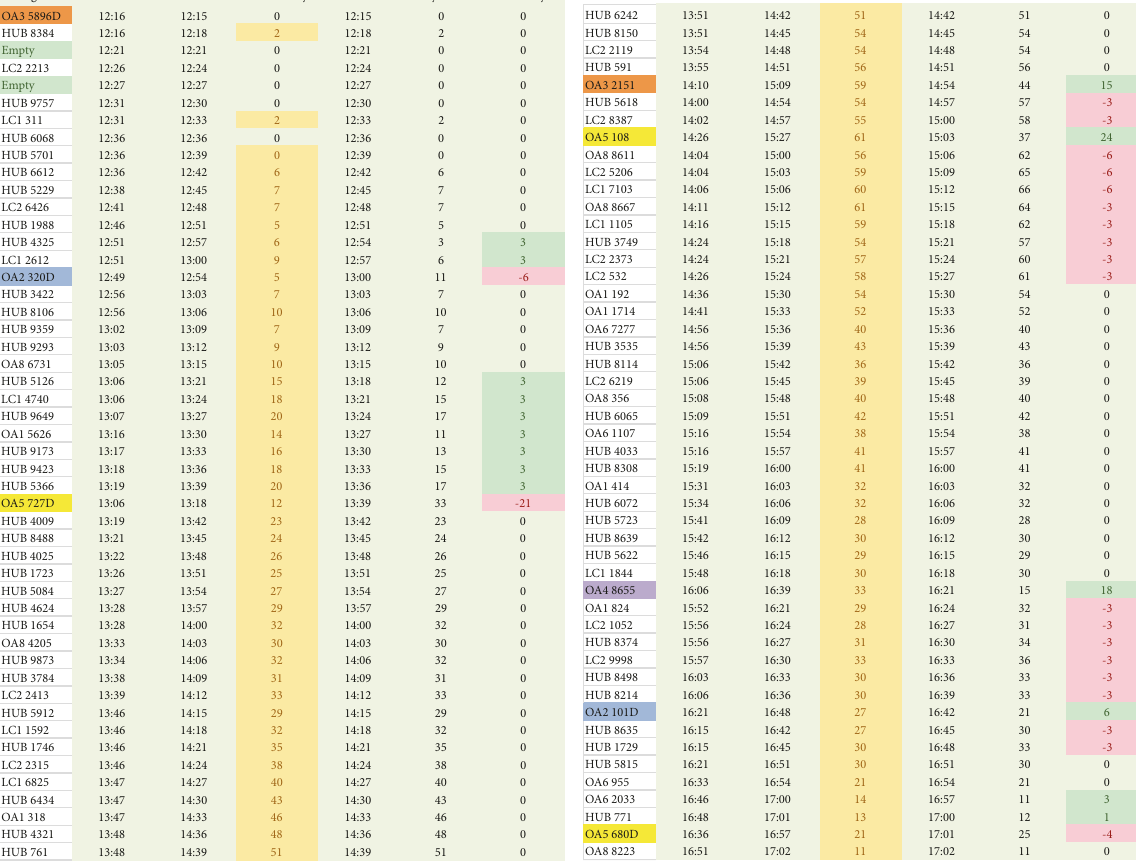
Figure 15: Impact of LVUC decision-making on the sequence and on the delay of flights (case study 3). Table 7: Effect of sequence compression on the AUs actual costs (case study